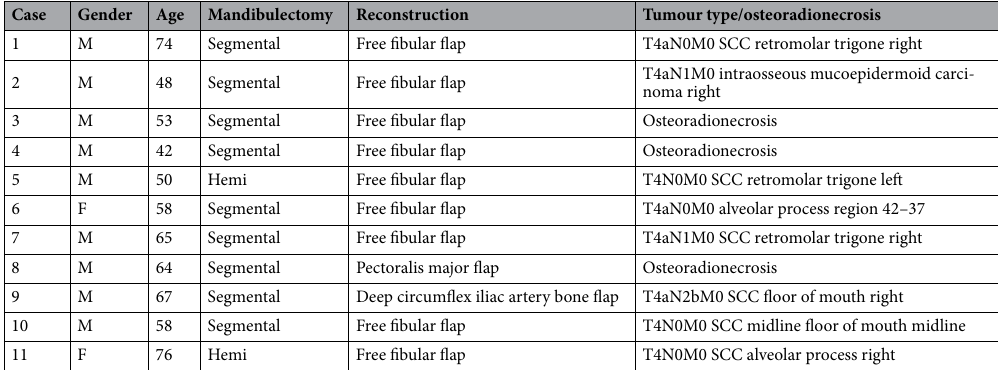
Table 1. Specifications and pathology outcomes of the surgeries of the patients included in the study. F female, M male, SCC squamous cell carcinoma.